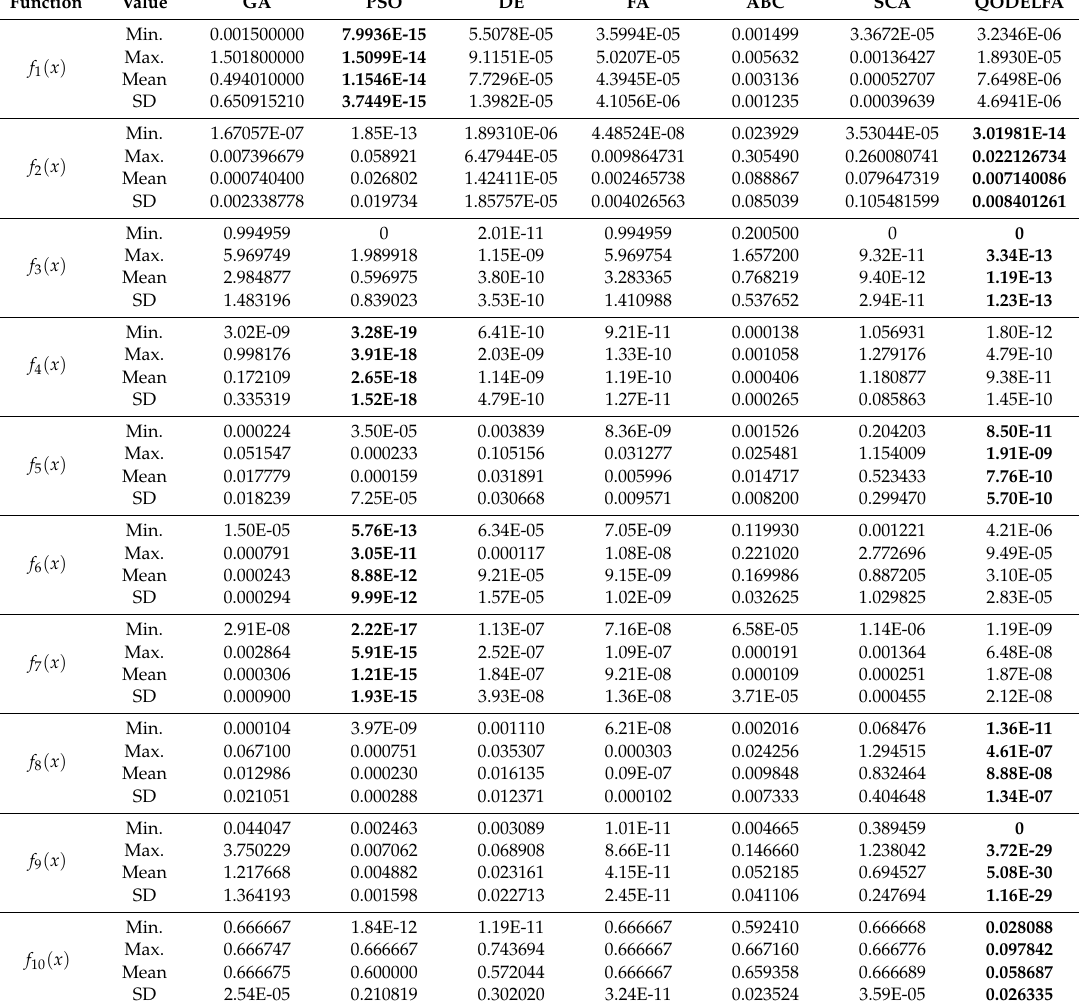
Table 2. Comparison of results for minimizing benchmark functions by using di ff erent